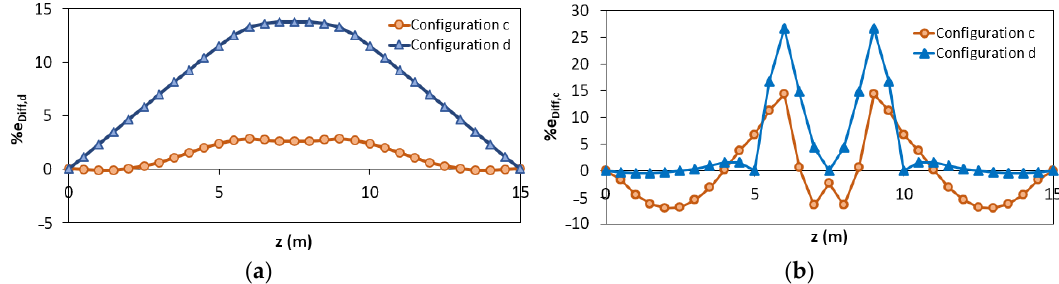
Figure 9. Percentage difference using configurations “c” and “d”: ( a ) iFEM-predicted displacements; ( b ) iFEM-predicted curvature.